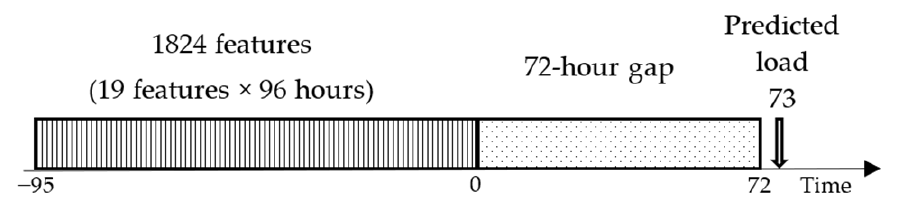
Figure 1. The scheme of making the forecast (experiment 1). After dividing the dataset, the subsets were preprocessed to form 96 blocks of features (for each hour) and the corresponding load after a 72-h gap, which resulted in the creation of the final training set of shape (38270,96,19) and the final testing set of the form